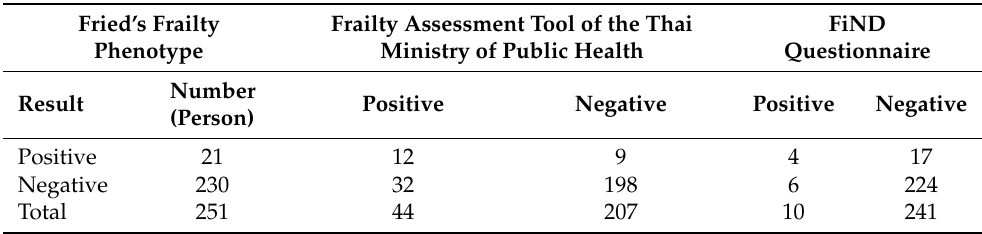
Table 4. Comparison of test results of the Frailty Assessment Tool of the Thai Ministry of Public Health, FiND questionnaire, and Fried’s Frailty Phenotype.